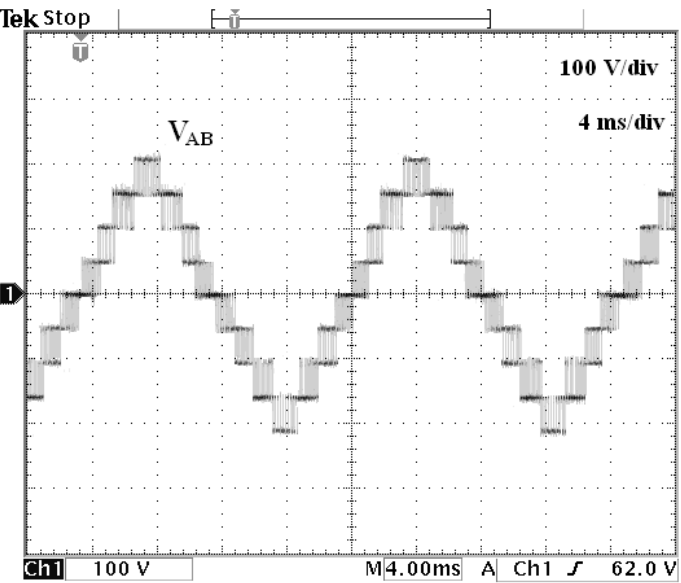
Figure 16. Line-to-line output voltage ( V AB ) of the five-level DCMC-based STATCOM.